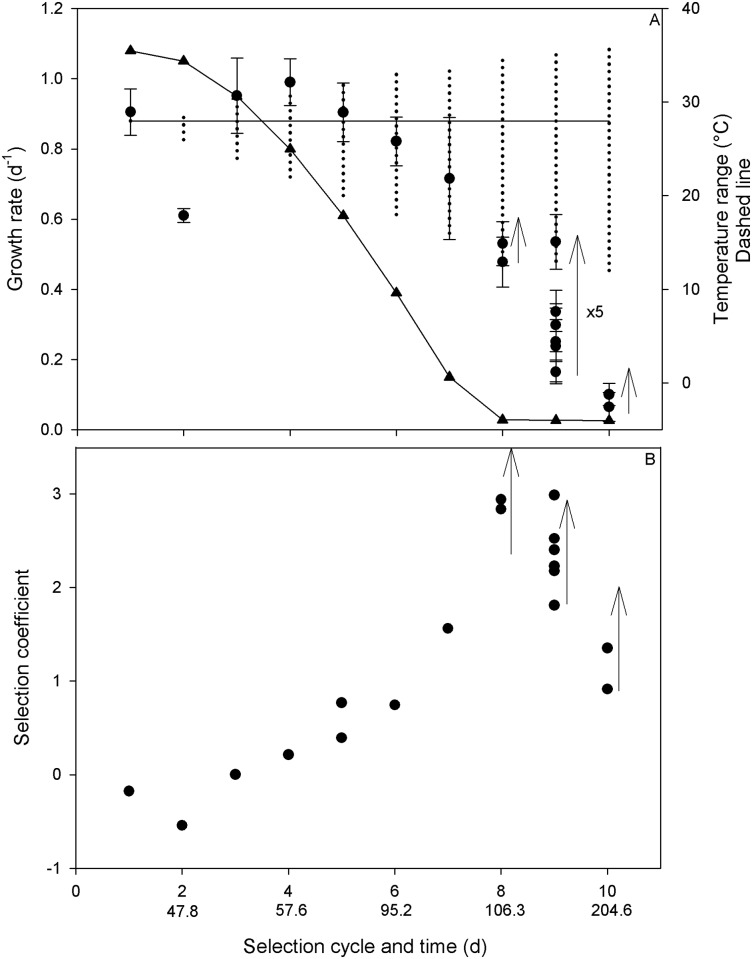
A) Mean growth rates measured for SFb strain during each selection cycle (black circles), and theoretical growth rate calculated with the calibrated temperature model of the initial strain W2X (triangles) submitted to the same temperature conditions. Growth rate was measured at a minimum of 6 different dates on one culture (SFb, n>6), during the exponential phase to achieve a linear regression with error < 5% and thus an accurate growth rate determination. The vertical dashed lines indicate the amplitude of temperature variations during each cycle, and the horizontal continuous line corresponds to the mean temperature maintained constant at 28°C throughout the selection experiment. B) Time change of the selection coefficient measured in SFb. When measured during consecutive weeks of the same cycle, the selection coefficient increased with time (vertical arrows).